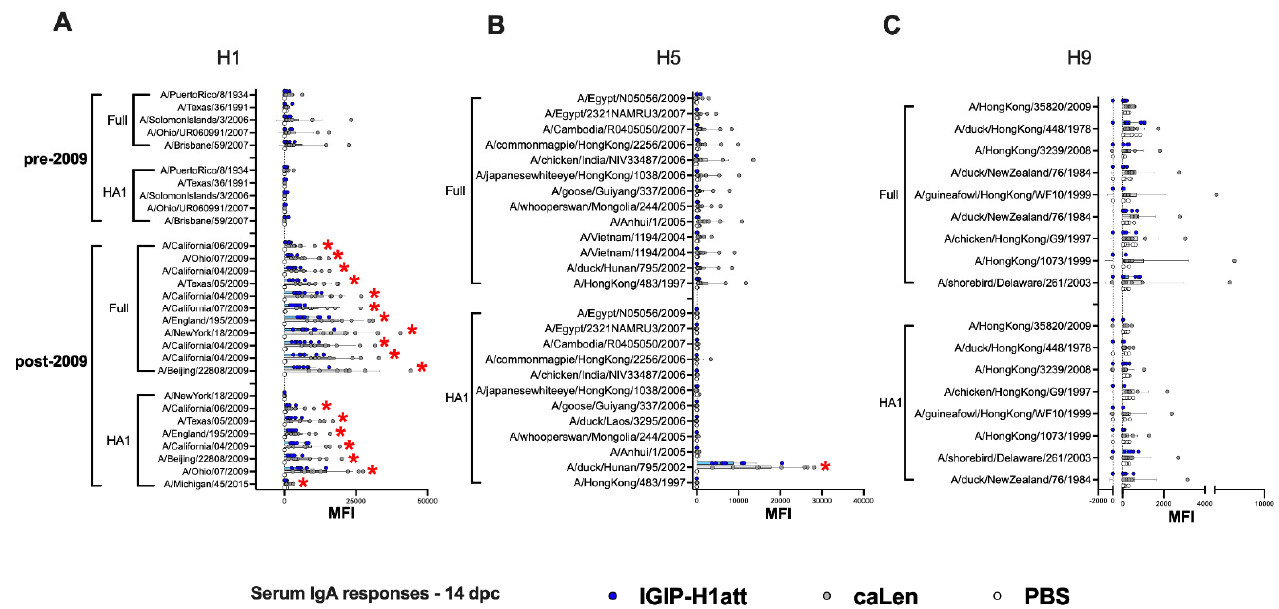
Figure 7. IgA serum responses 14 dpc in IGIP-H1att- and H1caLen-vaccinated mice. Same set of samples from Figure 6 probed for IgA antibodies against ( A ) H1, ( B ) H5 and ( C ) H9. The reactivity of serum samples is expressed as described in Figure 4 and results shown as MFI ± SD. The statistically significant differences between IGIP-H1att and caLen are depicted with red asterisks.